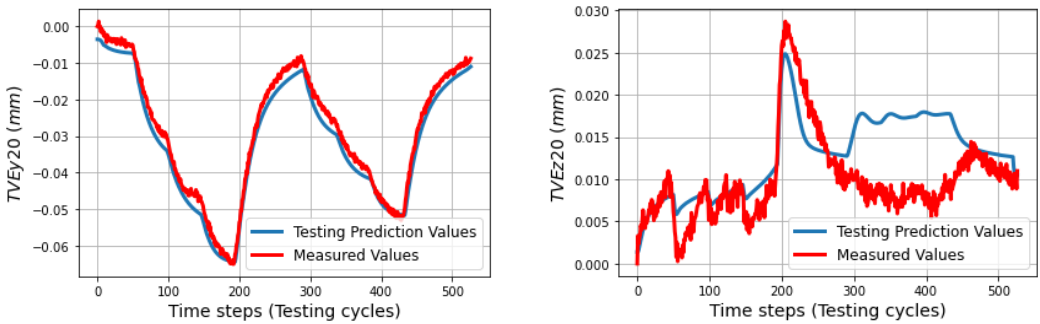
Figure 13. Prediction of TVEy20 and TVEz20 in the long process (LP) (1 cycle = 15 min).